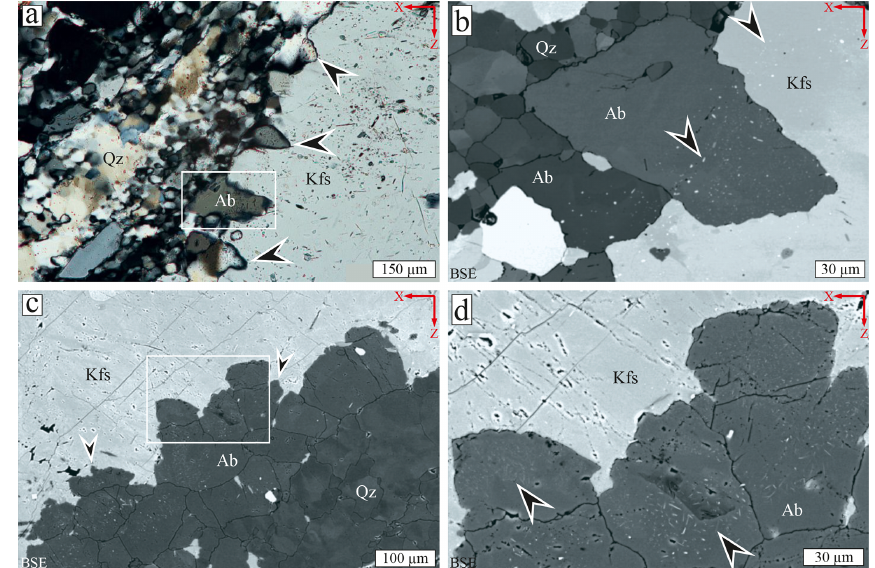
Figure 6. (a) Photomicrograph of cuspate interface between K-feldspar clast and new albite grains (sample CT599). (b) Close-up BSE image of location indicated by the white box in panel (a) . Note the tiny apatite inclusions in the albite (determined by EDS, arrows). (c) BSE image of cuspate interface between albite replacing K-feldspar in sample FH14. The arrows point to protrusions. (d) Close-up BSE image of the white box in panel (c) showing the numerous tiny ( < 5µm) apatite inclusions in the replacing